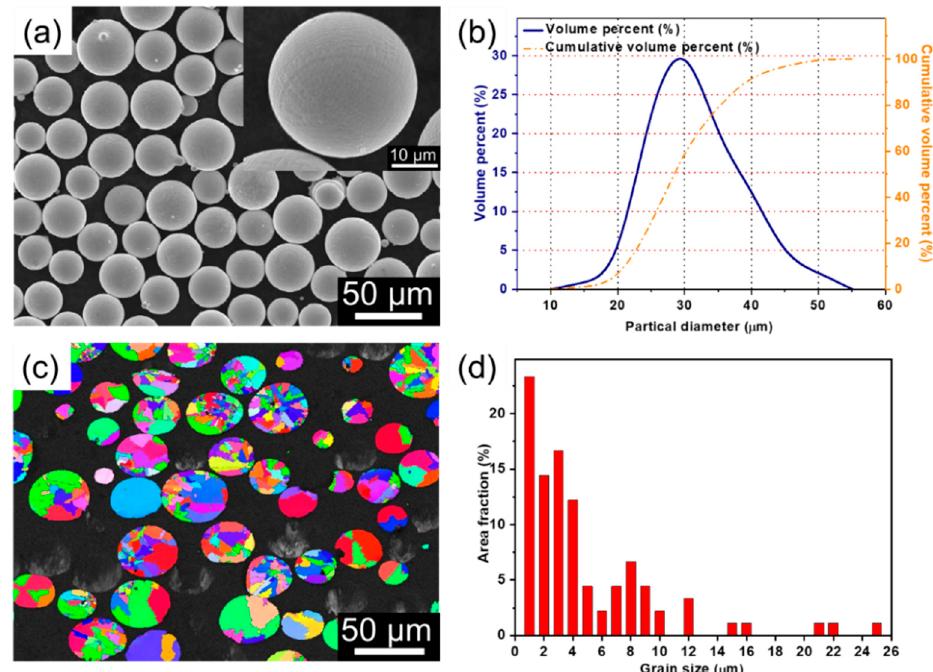
Figure 3. ( a ) SEM micrographs of IN718 powder feedstock in different magnifications, ( b ) particle size distribution, ( c ) inverse pole figure map of as-received IN718 powder, and ( d ) grain size distribution in as-received IN718 powder.